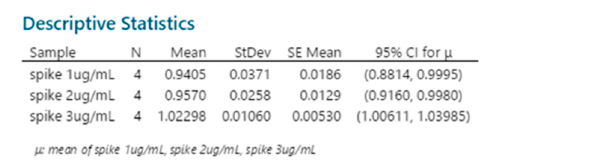
Figure A19. Spike recovery for HPAEC-PAD, confidence interval.